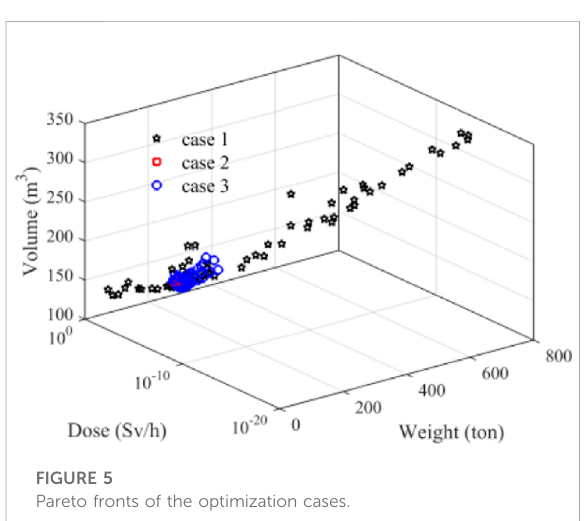
FIGURE 5 Pareto fronts of the optimization cases.